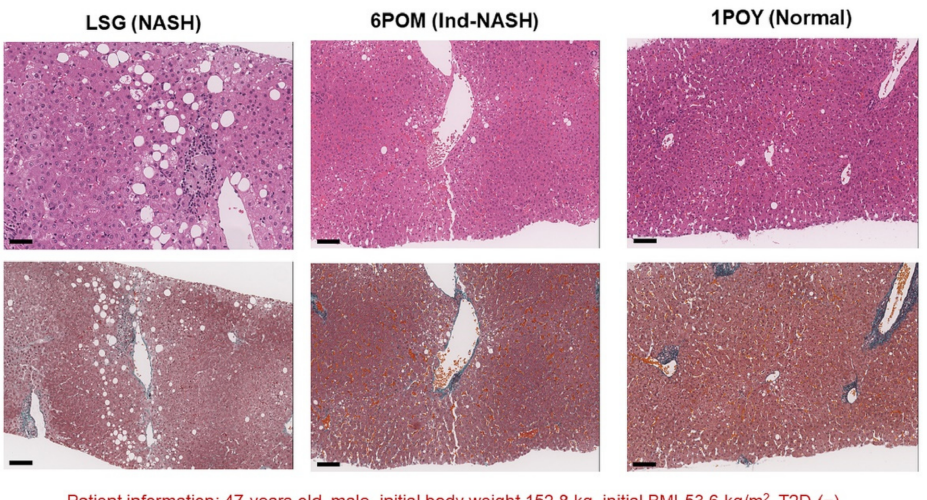
Figure 6. Protocol live biopsy confirmed sequential histopathological improvement in the patient with good weight-loss effects before and after LSG. BMI at LSG, 6 months after LSG (6POM), and 12 months after LSG (12POM) were 47.2 kg/m 2 , 43.6 kg/m 2 , and 40.0 kg/m 2 , respectively. The patient was able to achieve histopathological remission of NASH at 12 months after LSG. Small bars represent 50 µ m. Abbreviations: 6POM, 6 months after LSG; 12POM, 12 months after LSG. With regard to steatosis changes, the percentages of steatosis significantly improved at 6 months (7.5% vs. 25.2%; p < 0.05) and 12 months after LSG (8.0% vs. 25.2%; p <